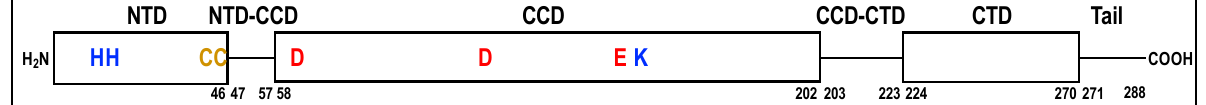
Figure 2. HIV-1 IN domains and phylogenetically conserved amino acid residues. Upper labels denote domains, interdomain linkers, and C-terminal tail region. Active site DDE residues are colored red, nitrogen-containing side chains blue, and cysteines are colored dark yellow. CCD residue Lys159, which is conserved among retroviral but not retrotransposon INs, interacts with the vDNA end [75,76]. Numbers, based on Ref. [77,78], denote domain and linker boundaries.